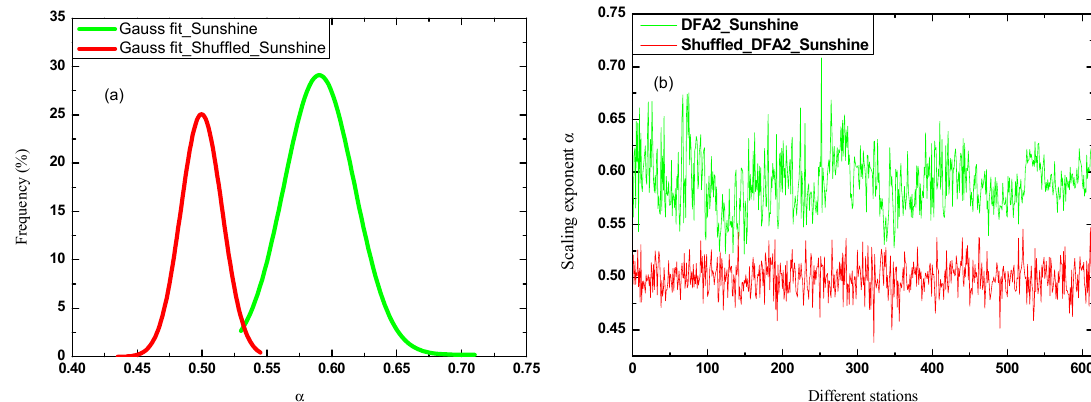
Figure 5. ( a ) Gaussian fit of the scaling exponents before and after shuffling the SSDA records for 615 stations across China. ( b ) The variations of the scaling exponents.